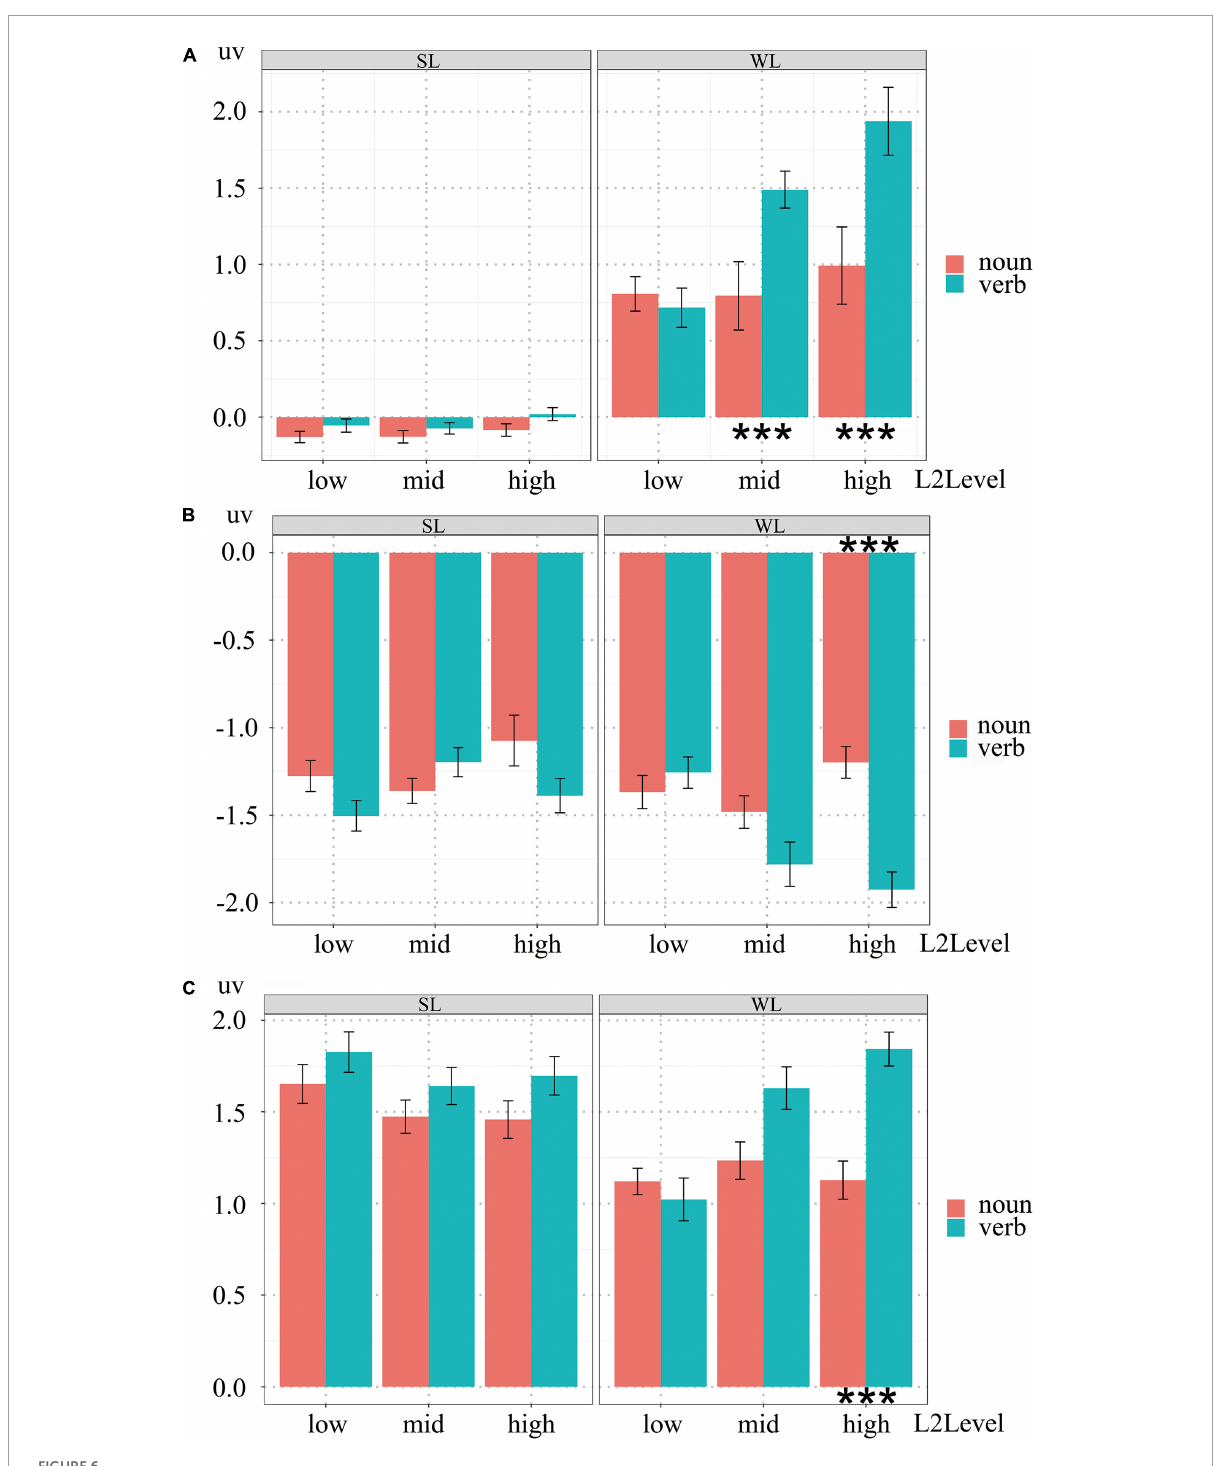
FIGURE6 (A) The dissociation of P200 effect between nouns and verbs in the three groups of native signers with different L2Level. Black stars indicate that signers with mid and high L2Level possessed significantly different P200 effect between processing nouns and verbs in written Chinese sentences ( p < 0.006). (B) The dissociation of N400 effect between nouns and verbs in the three groups of native signers with different L2Level. Black stars indicate that signers with high L2Level possessed significantly different N400 effect between processing nouns and verbs in written Chinese sentences ( p < 0.006). (C) The dissociation of P600 effect between nouns and verbs in the three groups of native signers with different L2Level. Black stars indicate that signers with high L2Level possessed significantly different P600 effect between processing nouns and verbs in written Chinese sentences ( p <